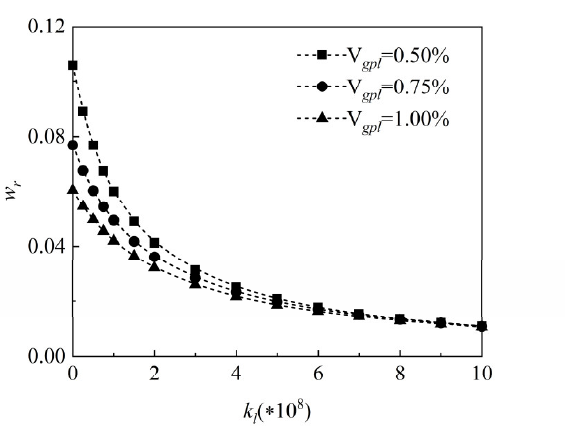
Figure 6. Variation of the percentage deflection change along the graphene length-to-thickness ratio for the ( a ) SSSS, ( b ) CCCC, ( c ) CCSS and ( d ) CSSS FG-GRP plates.